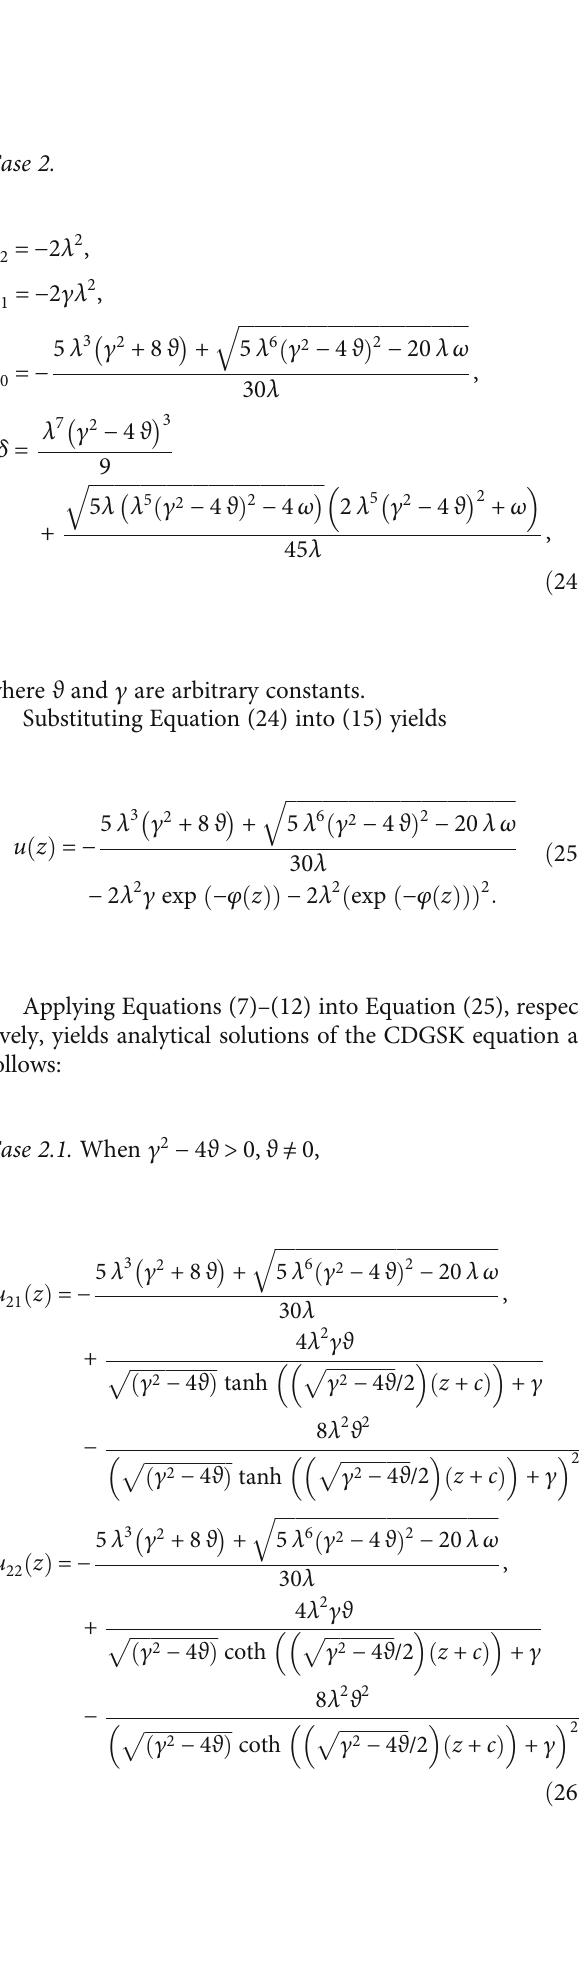
4 λ 2 γϑ p 4 ϑ − γ 2 ffiffiffiffiffiffiffiffiffiffiffiffiffiffi p tan 4 ϑ − γ 2